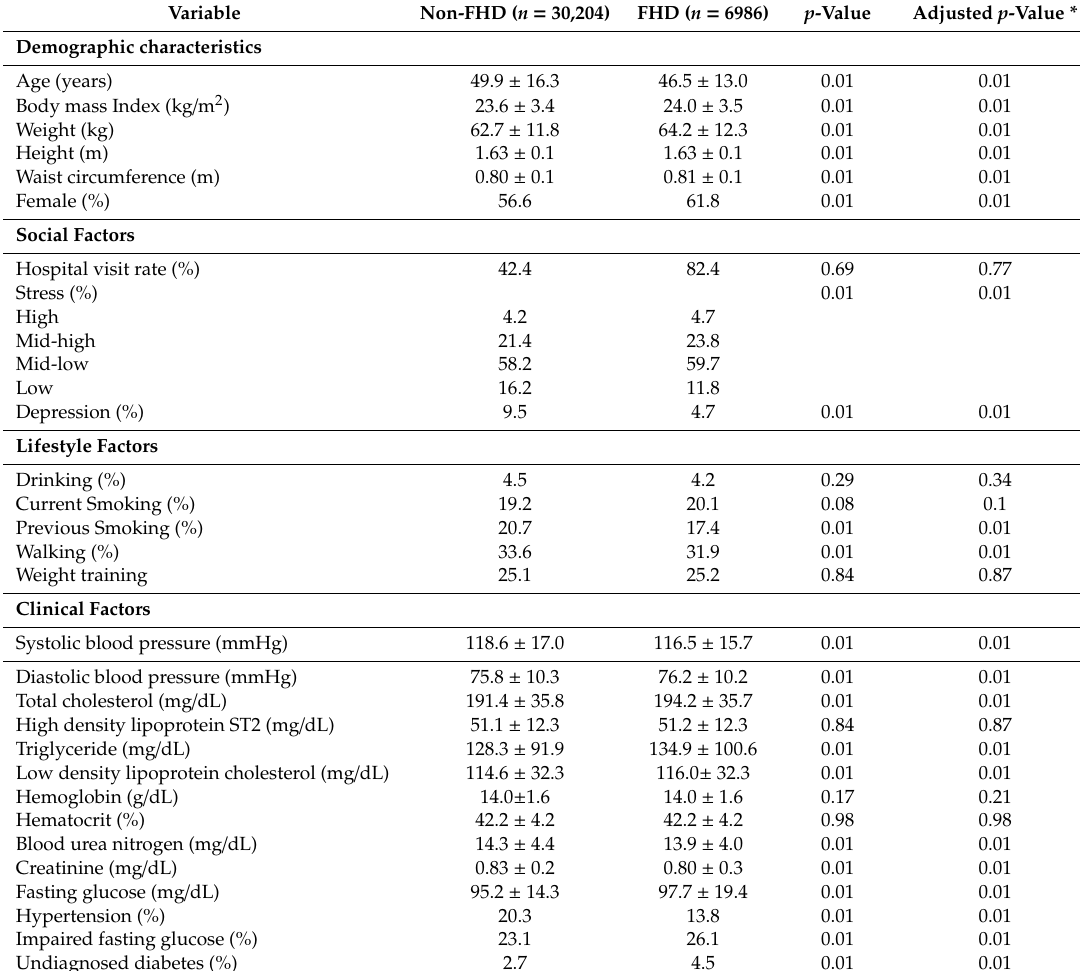
Table A2. Baseline characteristics of people with FHD and without non-FHD based on